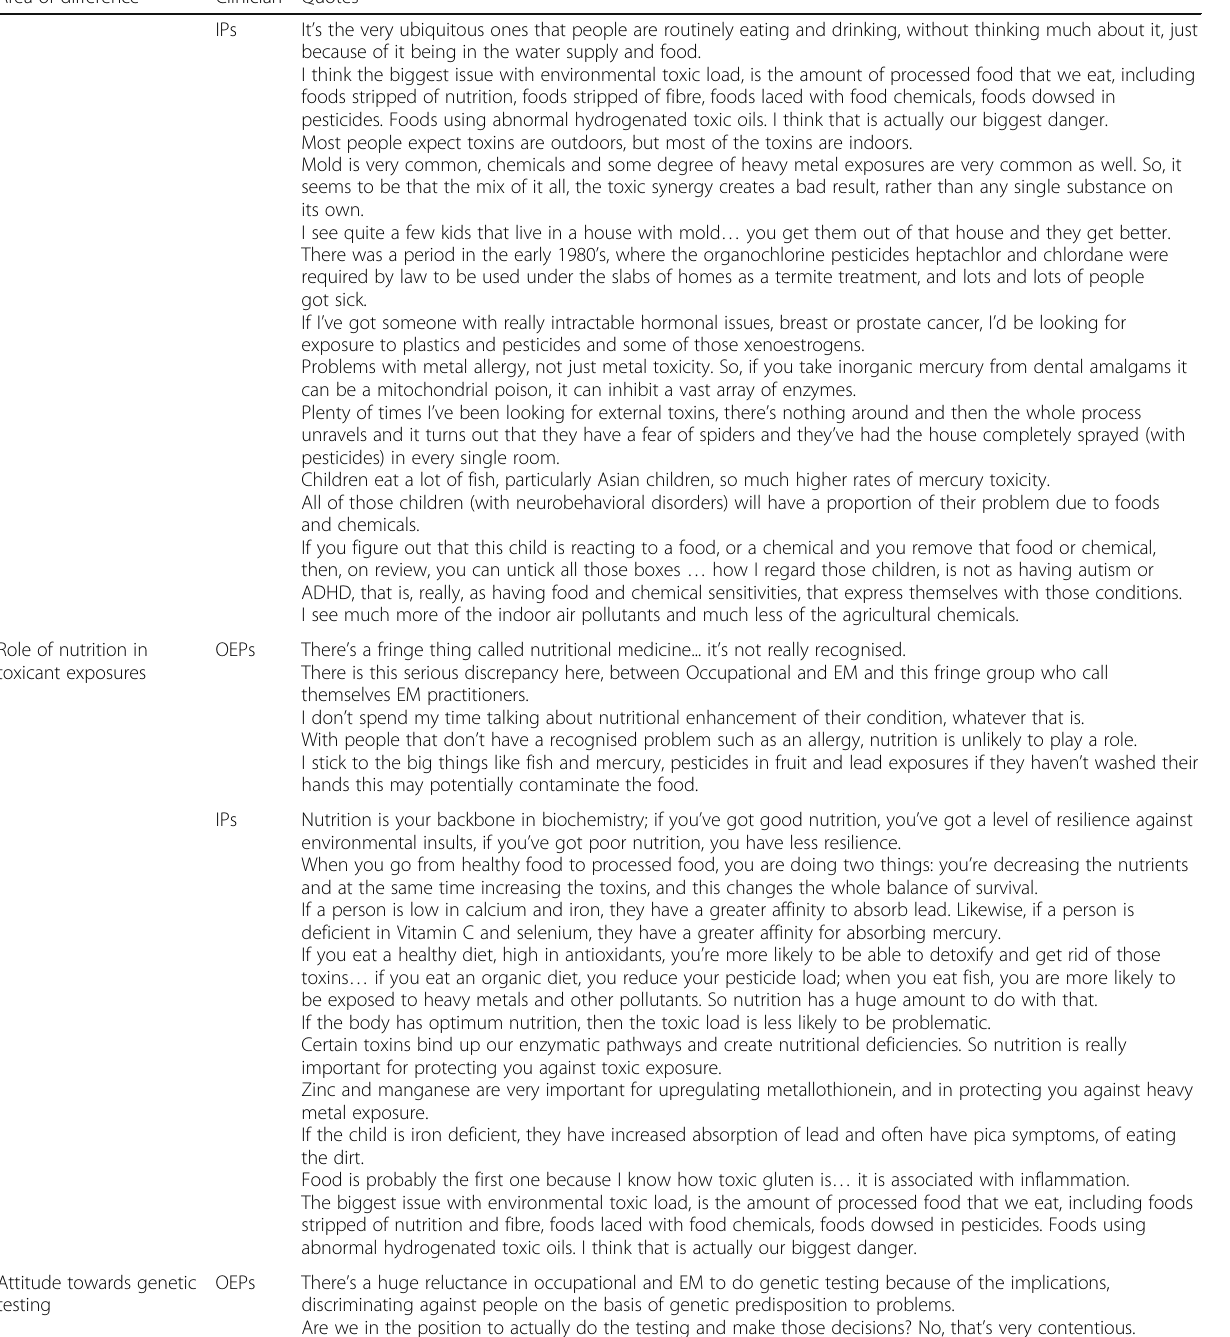
Table 1 Environmental medicine is a divided profession